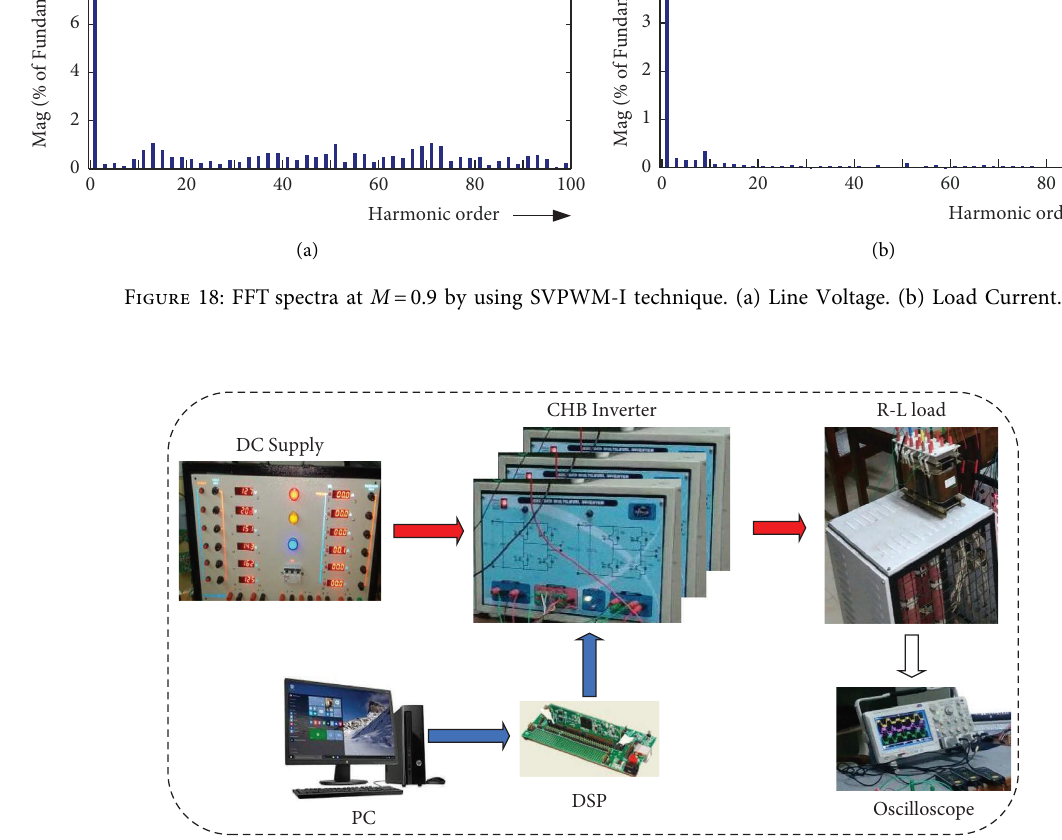
Figure 19: Hardware